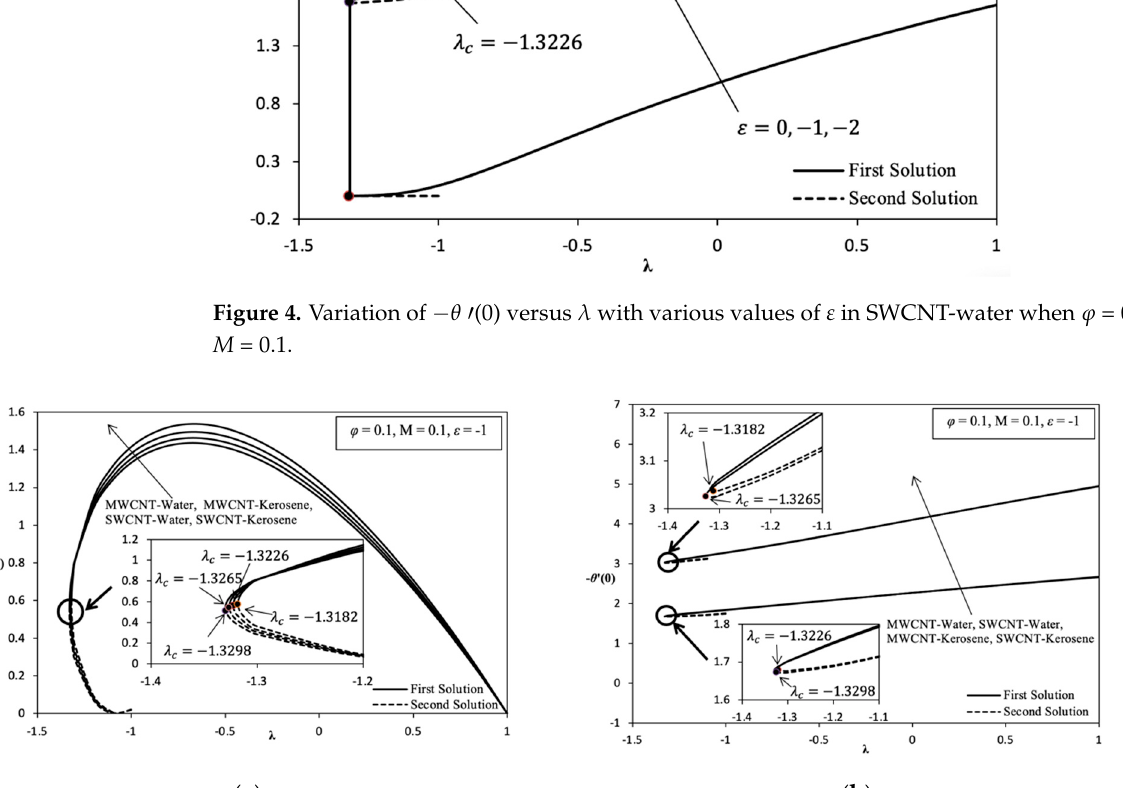
Figure 6. Variation on 𝜆 with various values of 𝜑 in SWCNT-water when 𝑀 = 0.1: ( a ) Variation on f ″ (0); ( b ) Variation on − 𝜃 ′ (0).